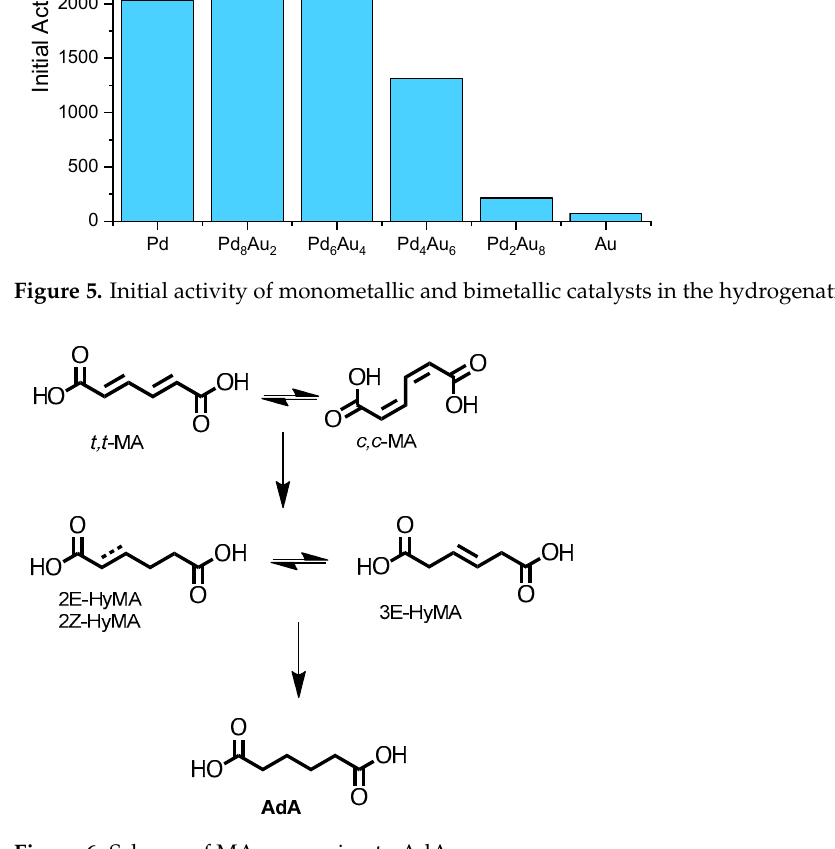
Figure 7. Intermediate selectivity after 30 min of reaction.